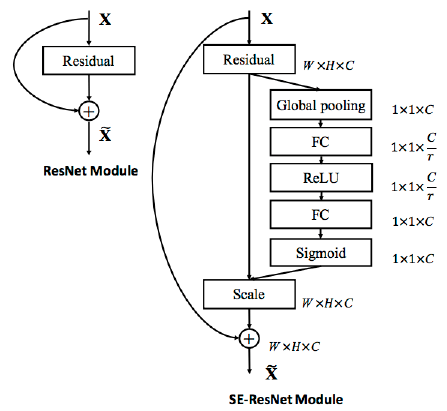
Figure 6. Architecture of the original inception module (left) and the SE-inception module (right).